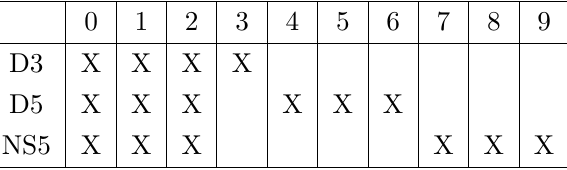
Table 1 . Brane array realizing 3d N = 4 A-type quiver theories.